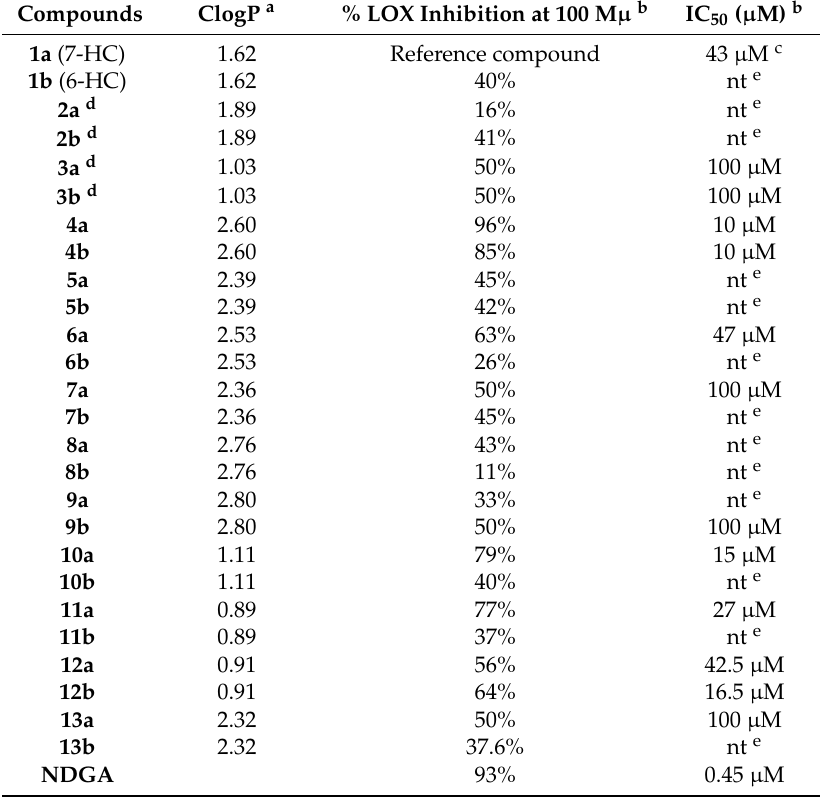
Table 2. In vitro inhibition of soybean LOX (IC 50 µ M or % LOX inhibition) [34] and lipophilicity values of 6- or 7- substituted coumarin derivatives 1 – 13 and their clogP